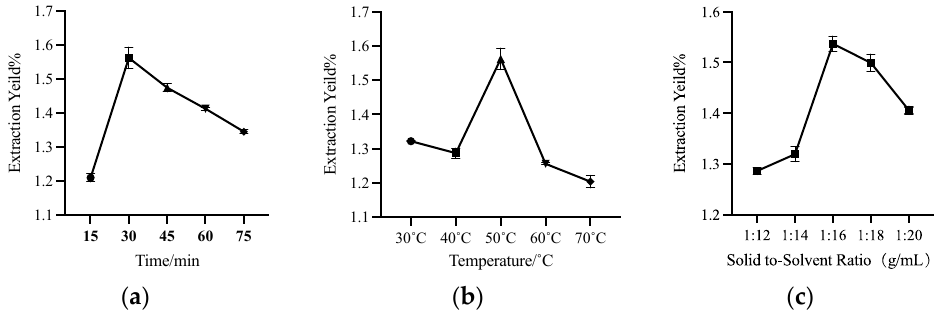
Figure 4. The effects of different time ( a ), temperature ( b ), and solid–liquid ratio ( c ) on the extraction yield of UA.